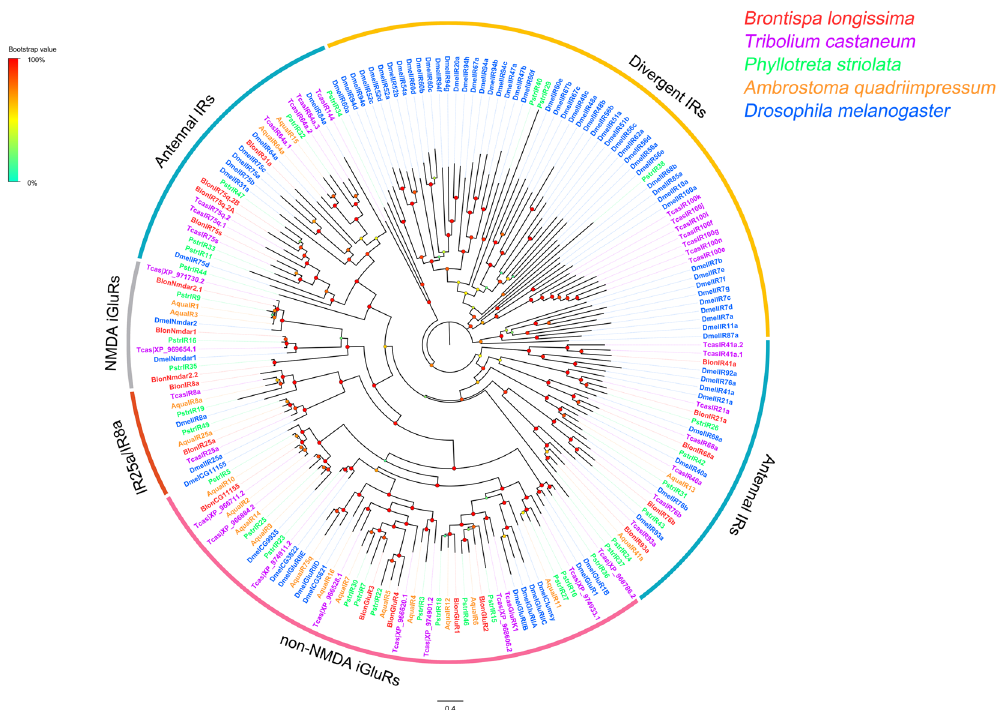
Figure 3. Phylogenetic tree of IRs from B. longissima (red labels), T. castaneum (purple labels) and other insects ( P . striolata , green labels; A . quadriimpressum , orange labels; Drosophila melanogaster , blue labels). The tree was constructed using FastTree 2.1.7 with the JTT substitution model, based on an amino acid alignment by MAFFT. Branch support (circles at the branch nodes) was estimated using an approximate likelihood ratio test based on the scale indicated at the top left. Bars indicate branch lengths in proportion to amino acid substitutions per site. IR prefixes indicate the following: Aqua, A . quadriimpressum ; Blon, B . longissima ; Dmel, D . melanogaster ; Tcas, T . castaneum